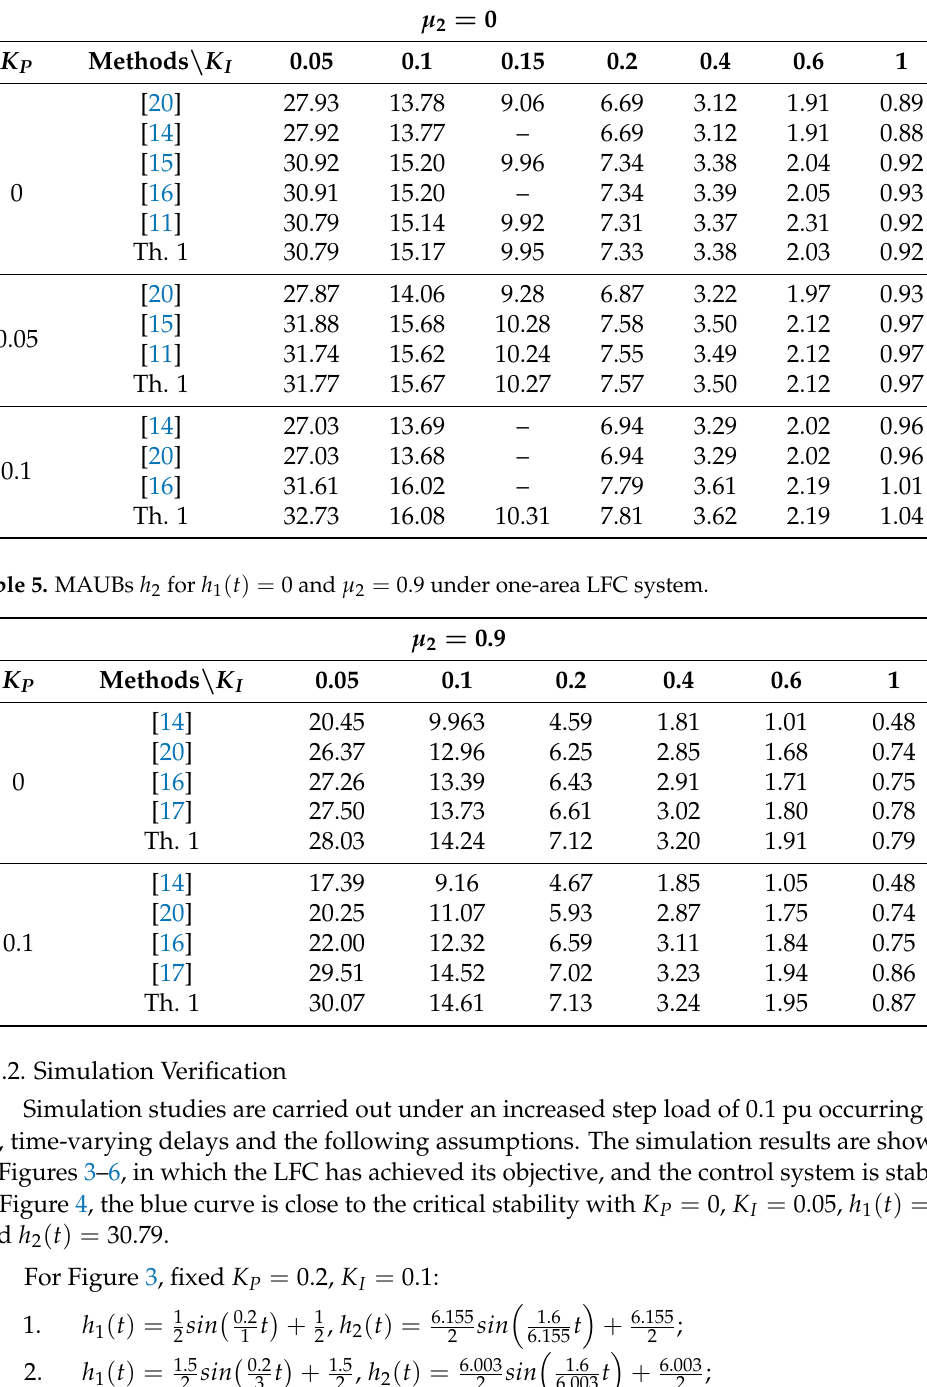
Table 4. MAUBs h 2 for h 1 ( t ) = 0 and µ 2 = 0 under one-area LFC system.